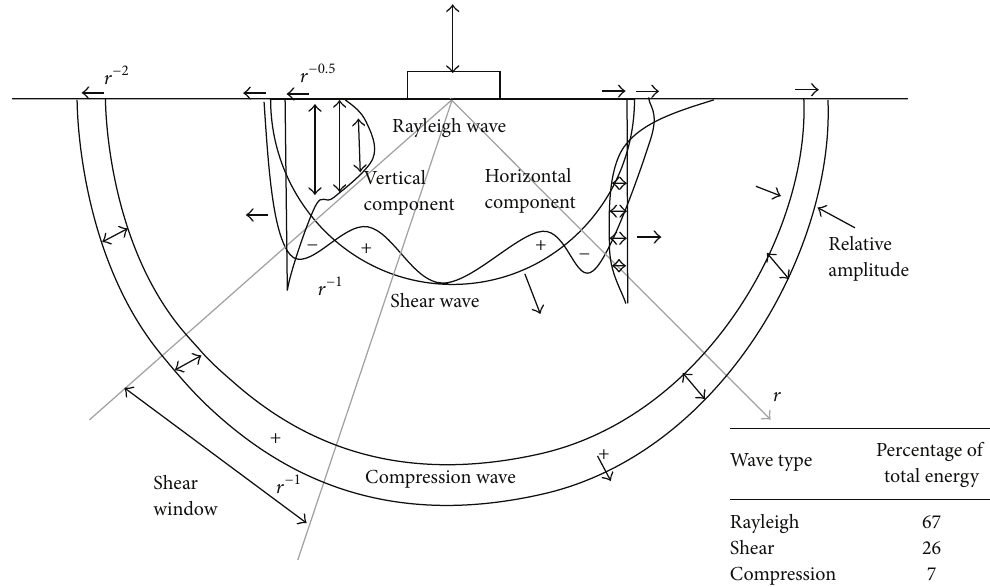
Figure 1: Distribution of displacement and energy in P-, S-, and R-waves from a harmonic normal load on a half-space for V = 0.25 [11].